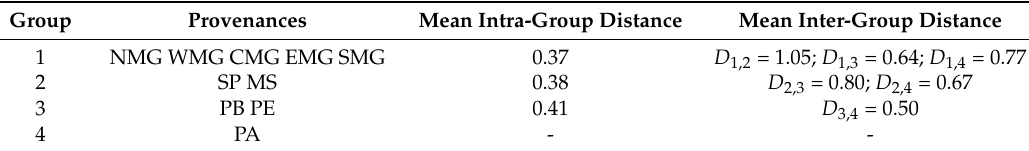
Table 4. Grouping of ten Acrocomia aculeata provenances using the method of Tocher. With Tocher, homogeneous groups are formed, as it uses least genetic distance at each stage of group formation. Hence, mean intra-group distance is always less than mean inter-group distance.